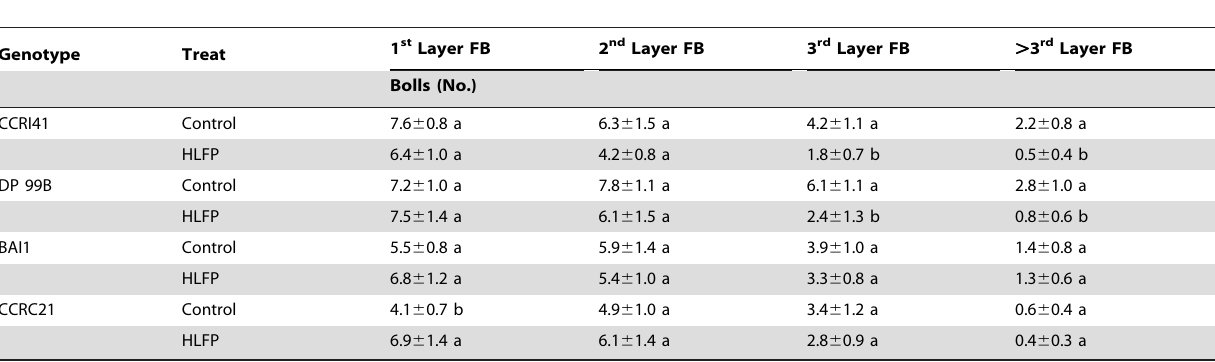
Table 5. Effects of mechanical stress caused by hanging labels from the petioles (HLFP) of every white flower in the field on the number of bolls found on fruiting branch (FB) layers in four cotton genotypes.